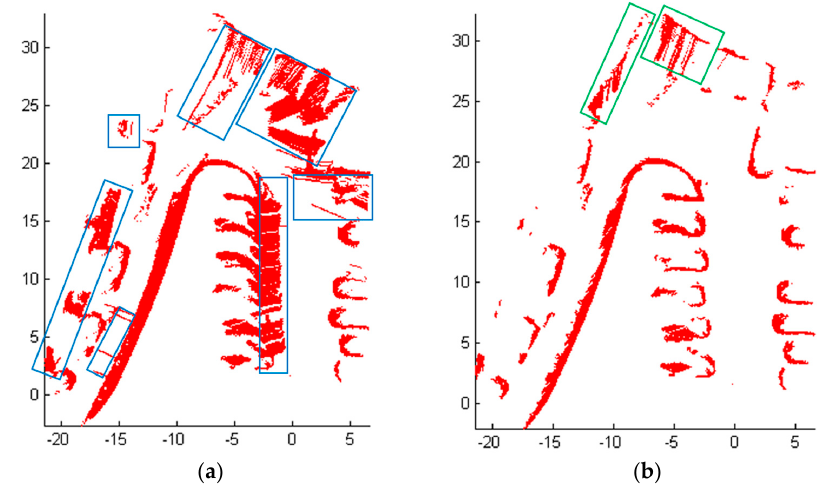
Figure 12. The comparison of detection results of Scene 3. ( a ) Using only the estimated vector; ( b ) Using only the estimated height.